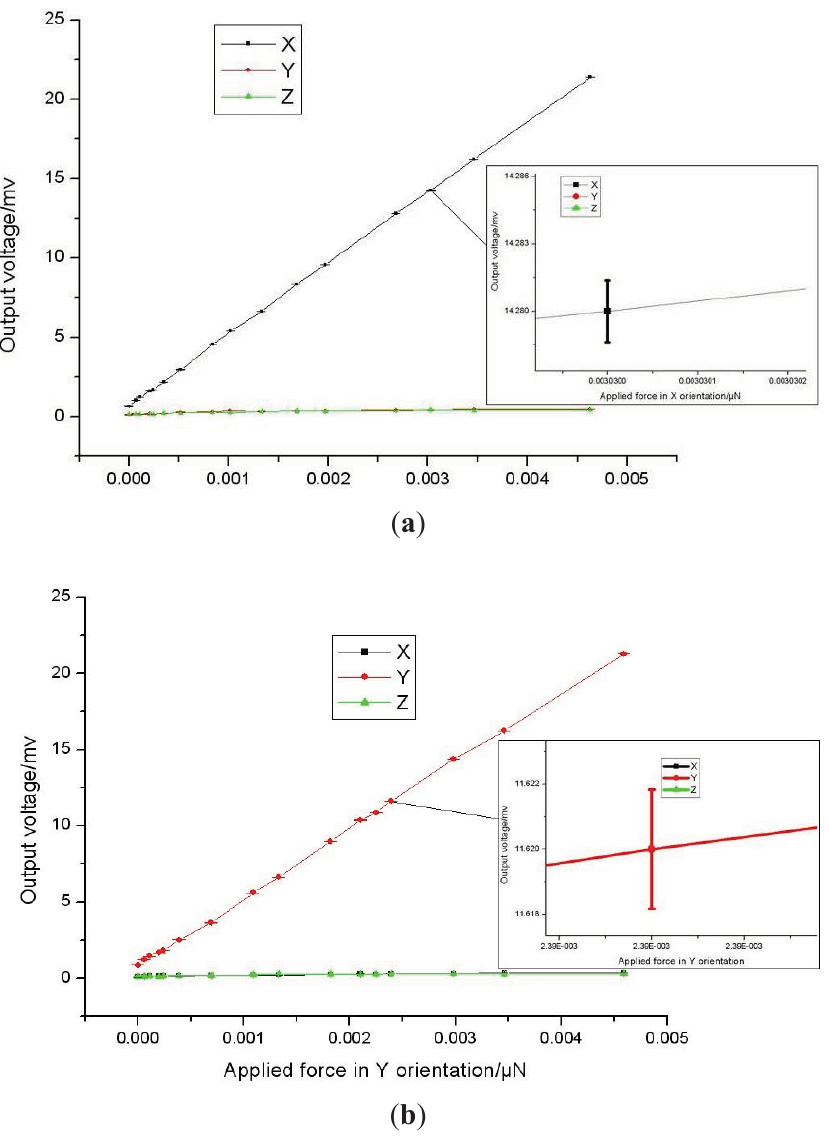
Figure 9. The output voltage of the micro-force sensor versus applied force. ( a ) Applied force in X orientation; ( b ) Applied force in Y orientation; ( c ) Applied force in